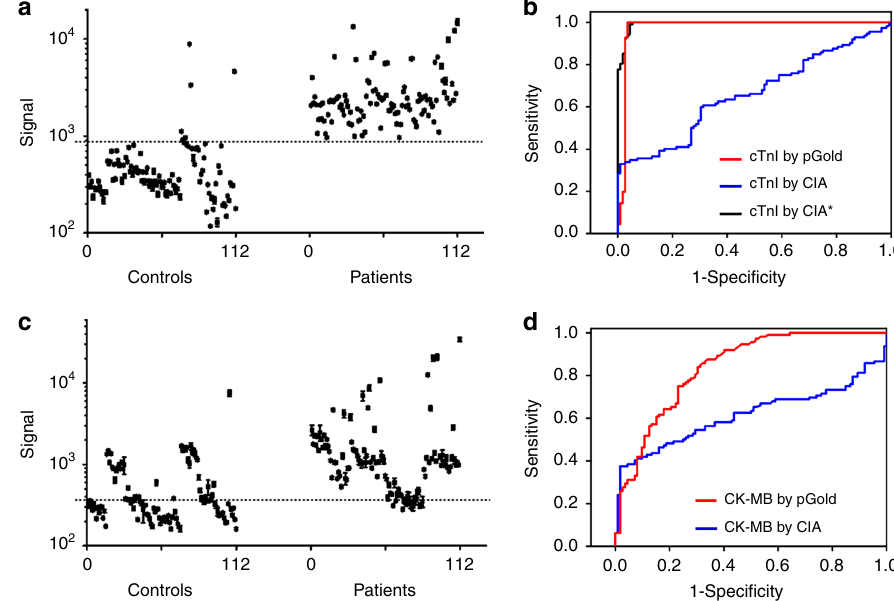
Fig. 3 Serum tests for diagnosis of MI using cTnI and CK-MB. a Signal quanti fi cation on pGold chips for the detection of 112 MI patients and 112 controls using cTnI. All experiments were conducted with n = 3; mean ± s.d. b ROC curves for diagnosis by cTnI. The red and blue lines represented pGold chips and CIA, respectively. The black line (CIA*) represented the CIA based on the Abbott Architect assay. c Signal quanti fi cation on pGold chips for the detection of MI patients and controls using CK-MB. All experiments were conducted with n = 3; mean ± s.d. d ROC curves for diagnosis by CK-MB. The red and blue lines represented pGold chips and CIA, respectively. The dashed lines were the intensity cutoffs corresponding to serum concentrations of 0.03 ng mL − 1 for cTnI and 3.13 ng mL − 1 for CK-MB. Source data are provided as a Source Data fi le. Table 2 Sensitivity and speci fi city with AUCs and CI using pGold chip and CIA.